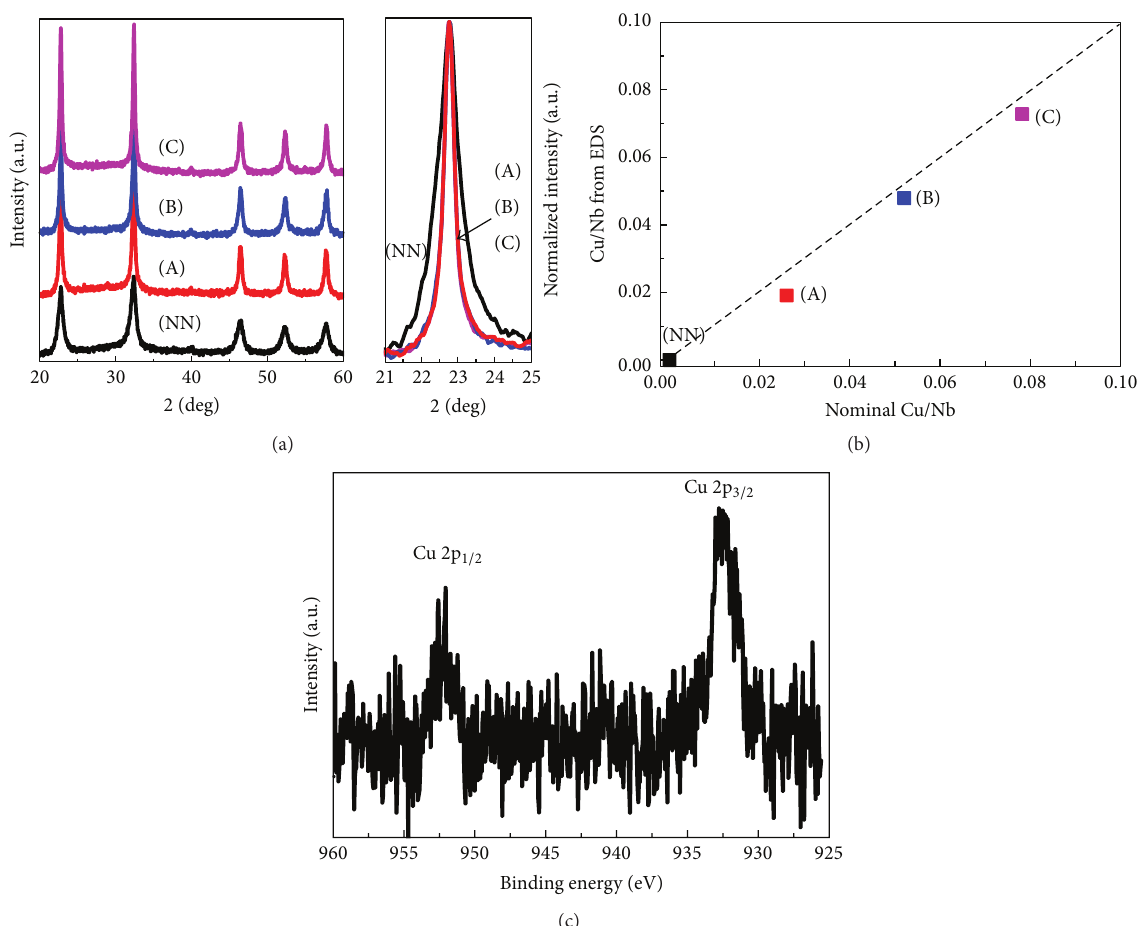
Figure 1: (a) X-ray diffraction patterns of NN, A, B, and C (left). Enlarged view of the main peak at 22.7 ∘ (right). (b) Cu/Nb ratio obtained from EDS analysis (black squares). The dash line represents the theoretical value. (c) Cu 2p line obtained from B.